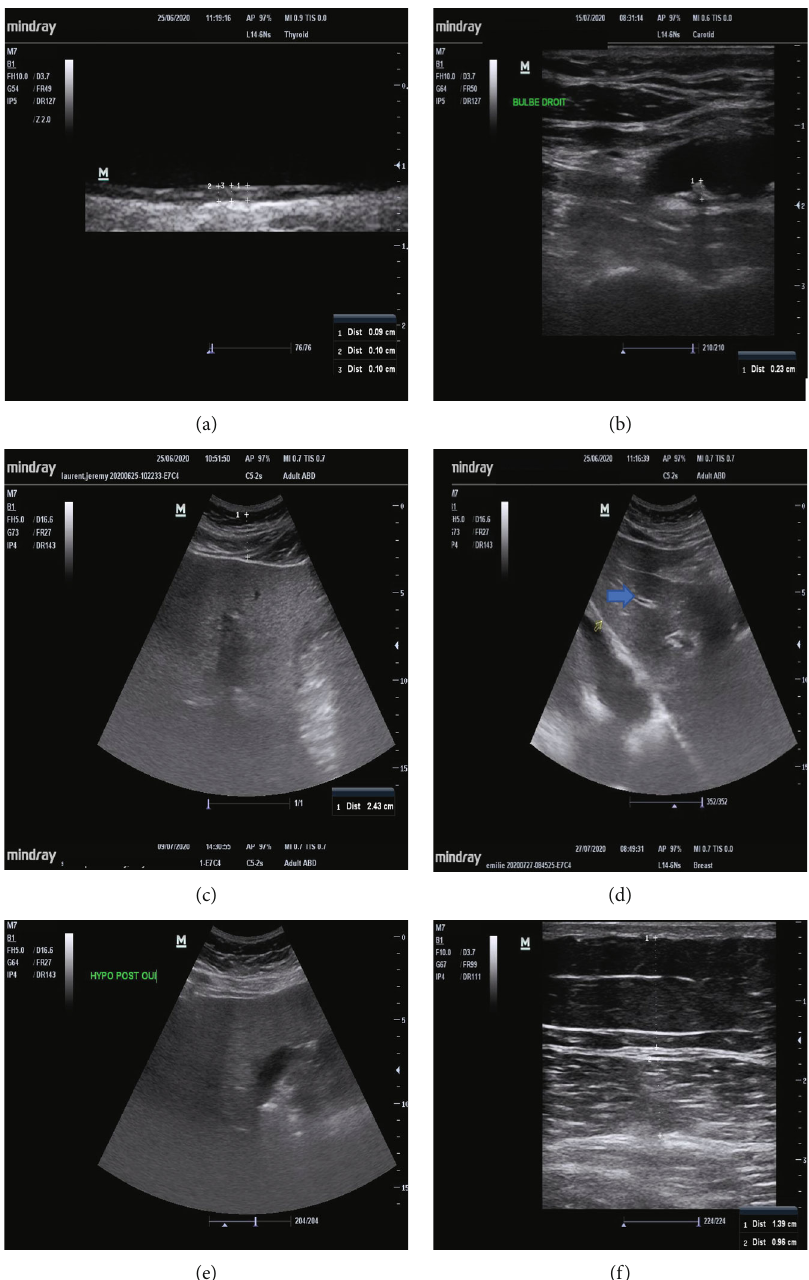
Figure 1: (a) Normal carotid artery ultrasonography. High-frequency probe. The intima media thickness is measured at three points. (b) Visualization of a plaque of 0.23mm thickness located near the carotid bifurcation. High-frequency probe. (c) Liver echography with determination of the skin capsular distance (2.43 cm). Low-frequency curvilinear probe. (d) Normal liver echography showing the portal veins (horizontal arrow), the diaphragm, and a homogeneous parenchyma. Low-frequency curvilinear probe. (e) Nonalcoholic steatohepatitis. This picture shows a rapid ultrasound attenuation. The vessels are attenuated, and the posterior liver is not seen. (f) Measurement of the rectus femoris (1) and vastus intermedius (2) thickness. High-frequency linear